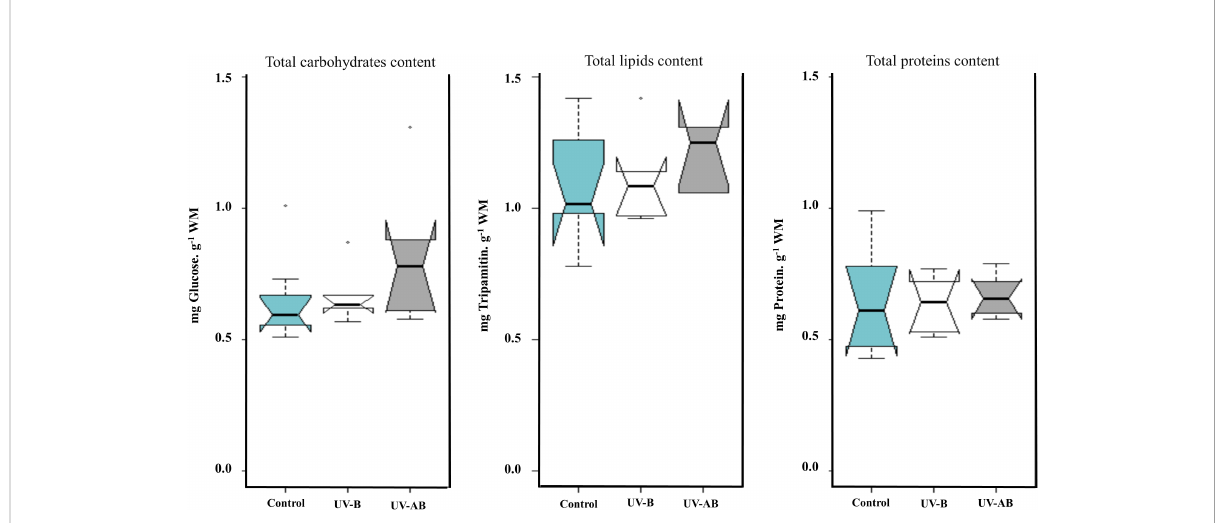
FIGURE 5 Cellular available energy ( Ea ) content in Cassiopea umbrella (bell) in response to UVR. Treatments were pairwise-compared to test for any signi fi cant differences in Ea (i.e., carbohydrates, lipids, and soluble protein). N = 8 (control), 6 (UV-B), and 6 (UV-AB). Statistical signi fi cance was tested using Kruskal – Wallis rank sum test.